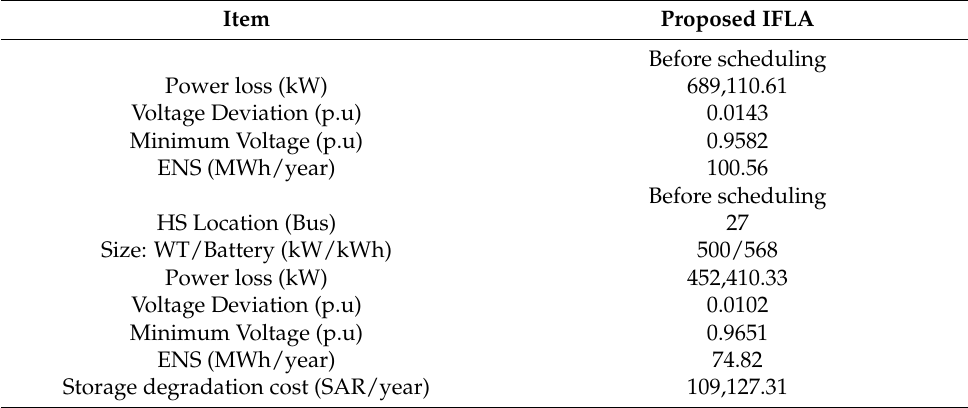
Table 9. The annual results of IFLA for scheduling of the hybrid WG/Battery system with storage degradation cost for 33-bus distribution system.